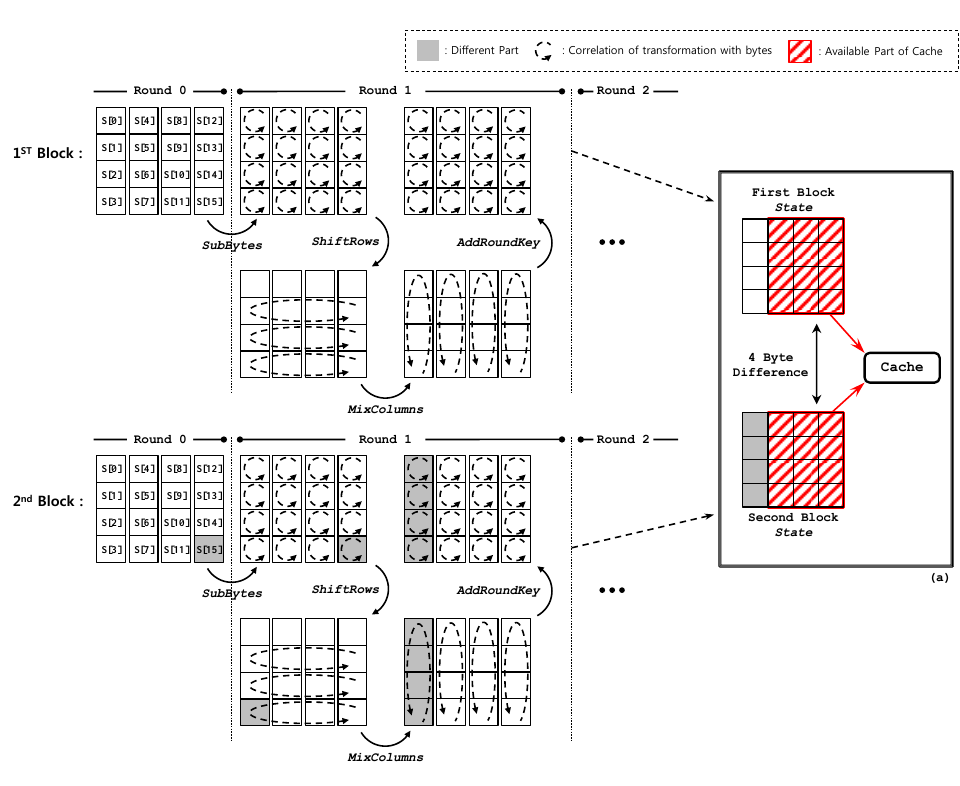
Figure 4: FACE rd 1 : The process of AES round 1 and the diffusion of the difference between the first block and the second block. (a) represents the cached part used by FACE